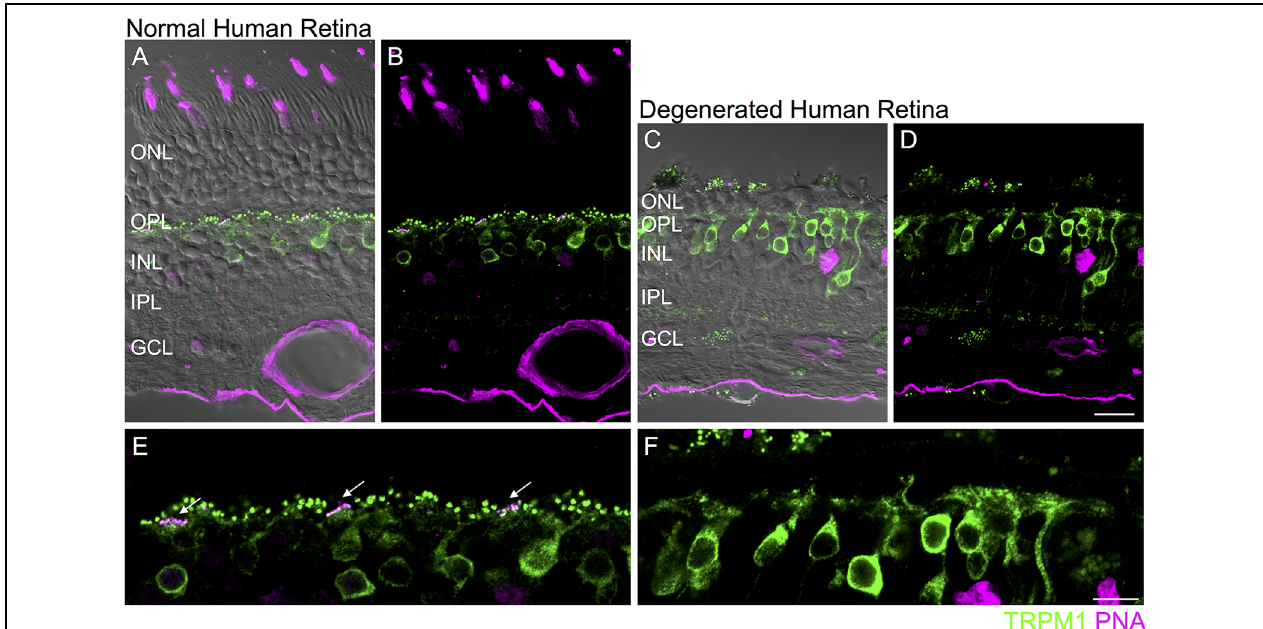
FIGURE 5 | Loss of synaptic TRPM1 after photoreceptor degeneration in human retina. (A–D) Immunolocalization of TRPM1 (green) and PNA (magenta) in normal human peripheral retina (A,B) and in degenerated human retina (C,D) . The fluorescence image is superimposed on the transmitted light image (gray) to show retinal morphology. Scale bar = 20 μ m. (E,F) : High magnification view of the normal (E) and degenerated (F) outer retina. In the normal retina (E) , punctate TRPM1 immunolabeling is present in the outer plexiform layer as well as in the somata and dendritic tips of ON bipolar cells. Clusters of TRPM1 staining are associated with PNA-labeled cone pedicles (arrows). (F) Immunolocalization of TRPM1 (green) and PNA (magenta) in human retina after extensive photoreceptor degeneration. There is loss of synaptic punctate staining but strong somatic staining remains. Scale bar = 10 μ m.